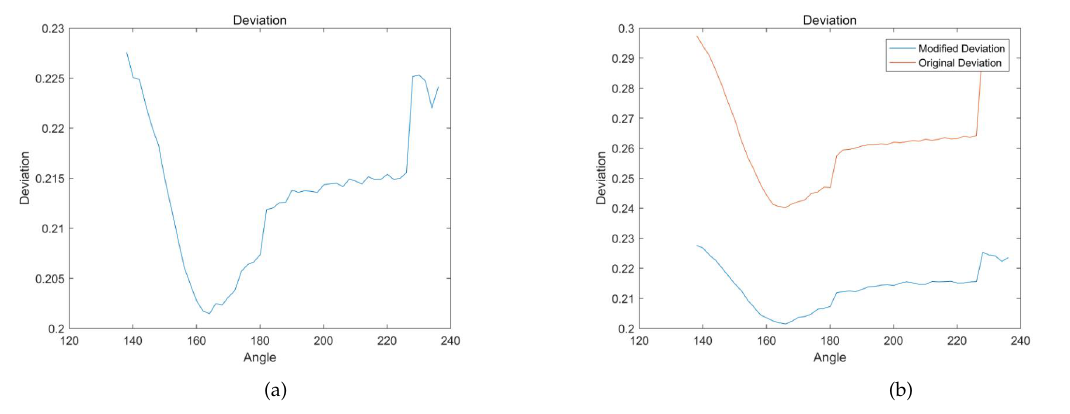
Figure 13. ( a ) The modified deviations; ( b ) The comparison of original and modified